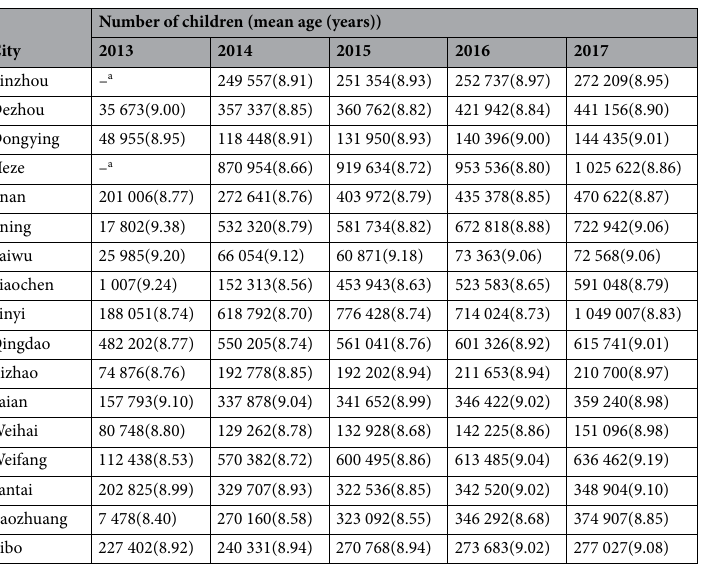
Table 1. Information of children in different cities of Shandong province from 2013 to 2017. a The symbol (‘-’) represents a missing